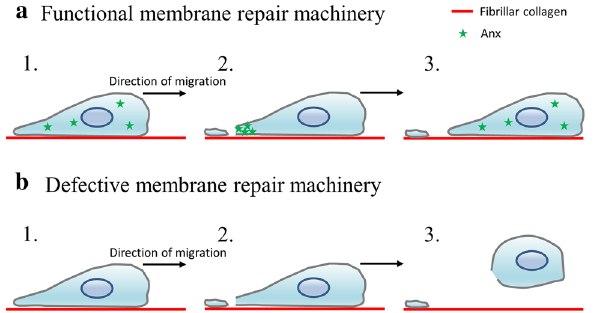
Figure 10. Model of migration of MDA-MB-231 cells equipped with a functional or defective membrane repair machinery. ( a ) In wild-type cells, migration on fibrillar collagen I induces the release of membrane fragments responsible for membrane injuries (Step 1). Anx, notably AnxA5 and AnxA6, are recruited to the disruption site, where they promote membrane repair (Step 2). Once the cell is repaired, Anx return to the cytosol (Step 3). ( b ) In cells presenting defective membrane repair, due for example to the absence of Anx, membrane injuries created by the migration on collagen I fibrils are not resealed (Step 2). This leads to the death of cells, which are released from the substrate (Step